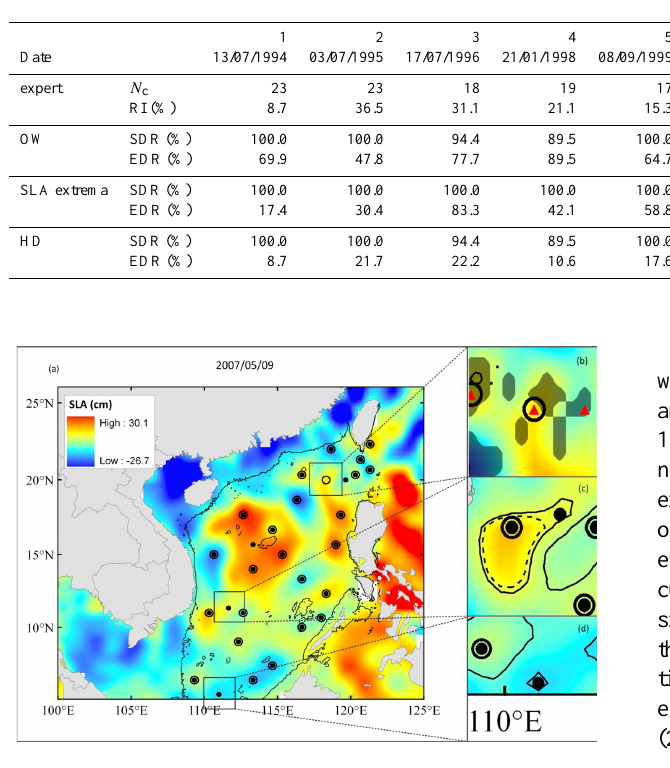
Fig. 6. (a) Comparisons between experts’ detection result and HD’s Figure 6. (a) Comparisons between experts’ detection result and HD’s result on May 9 th , 2007. 3 result on 9 May 2007. The 100m depth isobath is delineated by the The 100 m depth isobath is delineated by the black solid line. The circles represent eddies 4 black solid line. The circles represent eddies identified by experts, identified by experts while the dots represent the ones identified by HD. These detection 5 while the dots represent the ones identified by HD. These detec- results are superposed on SLA field of that date. (b) One missed eddy in HD’s result. Red 6 tion results are superposed onto the SLA field of that date. (b) One triangles represent the SLA local extrema, and the grey polygons represent eddies’ core areas. 7 missed eddy in HD’s result. Red triangles represent the SLA lo- (c) One over-detected eddy that constitutes a multi-core structure. The composite borders are 8 cal extrema, and the grey polygons represent eddy core areas. (c) delineated by the solid lines and the footprint borders by the dashed lines. (d) The other 9 One over-detected eddy that constitutes a multi-core structure. The over-detected eddy located near the border of study region. 10 composite borders are delineated by the solid lines and the foot- print borders by the dashed lines. (d) The other over-detected eddy located near the border of the study